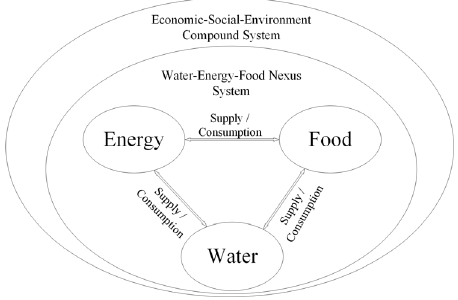
Figure 2. Water–energy–food symbiotic system.